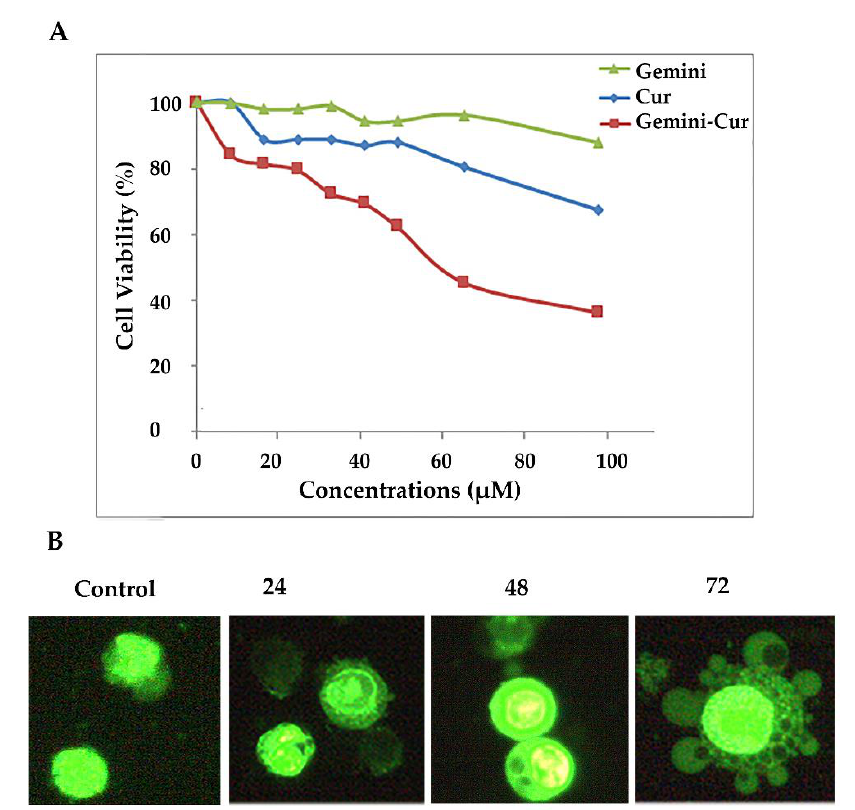
Figure 1. Gemini-Cur affects the proliferation of HCT-116 cells. ( A ): Gemini-Cur suppresses HCT-116 cells proliferation in a time- and dose-dependent manner. ( B ): Acridine orange/ethidium bromide staining also illustrated cells with apoptotic characteristics including membrane shrinkage and nuclear fragmentation in different incubation times (24, 48 and 72 h, Magnification ×400). Gemini: gemini surfactant nanoparticles; Cur: curcumin; Gemini-Cur: gemini curcumin .